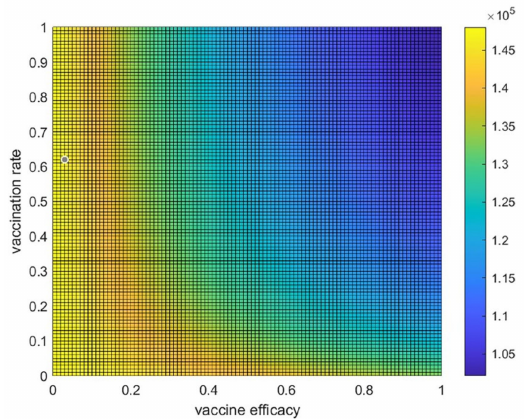
Figure 8. The trade-off between vaccine efficacy and the vaccination rate. Heatmap or two- dimensional plot of the average number of hospitalized individuals per day from the trade-off between vaccine efficacy and vaccination